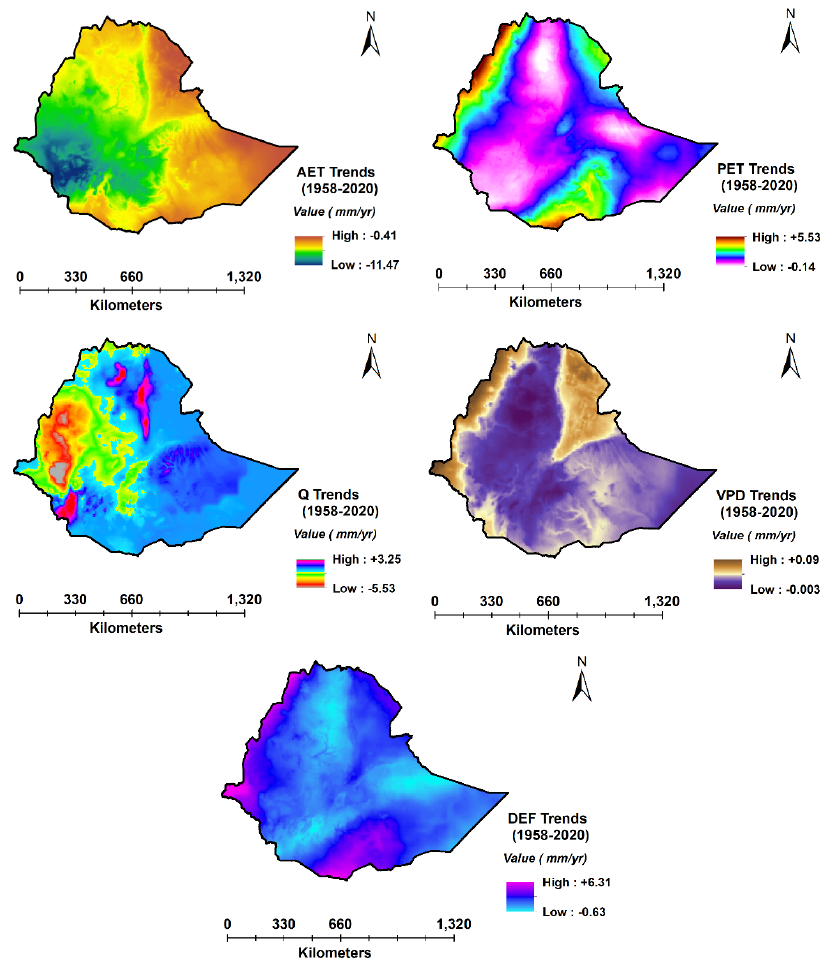
Figure 8. Spatial distribution of the AET, PET, Q, VPD and DEF trend (slope of the linear regression) map for 1958–2020 in the study of Ethiopia.